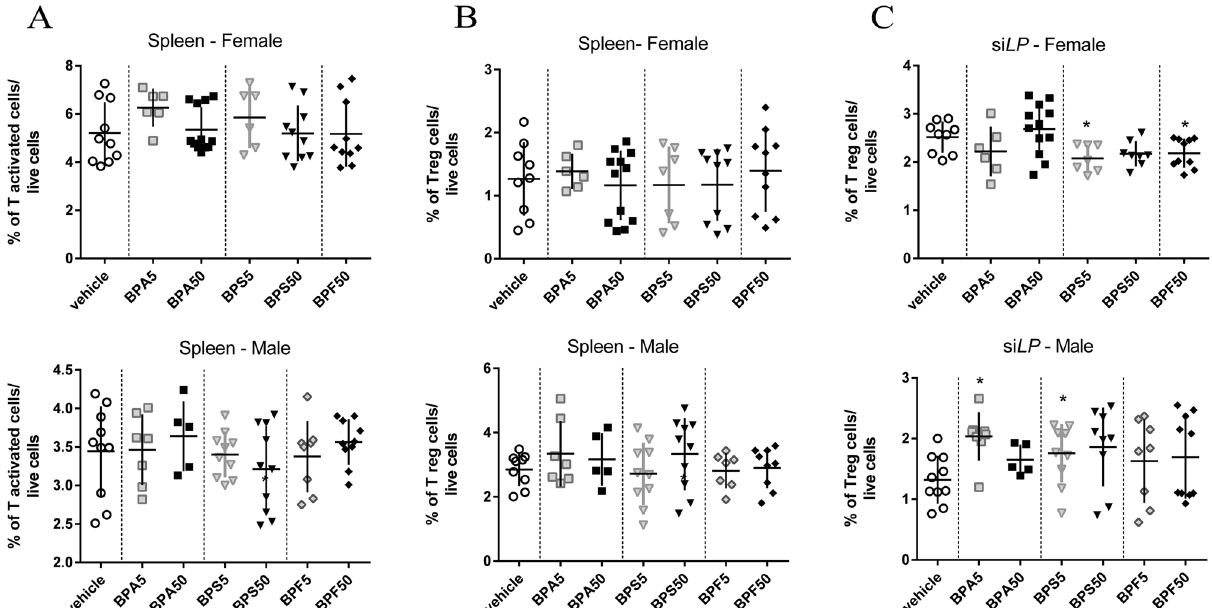
Figure 4. Effects of dermal exposure to bisphenols on the immune homeostasis of adult offspring mice. Proportion of CD4 + CD44 high CD62L low T-activated cells in spleen ( A ) and CD4 + CD25 + FoxP3 + Treg cells in spleen ( B ) and si LP ( C ) of female and male offspring mice at PND70. *P < 0.05 vs. vehicle group. N = 5–12 offspring mice per